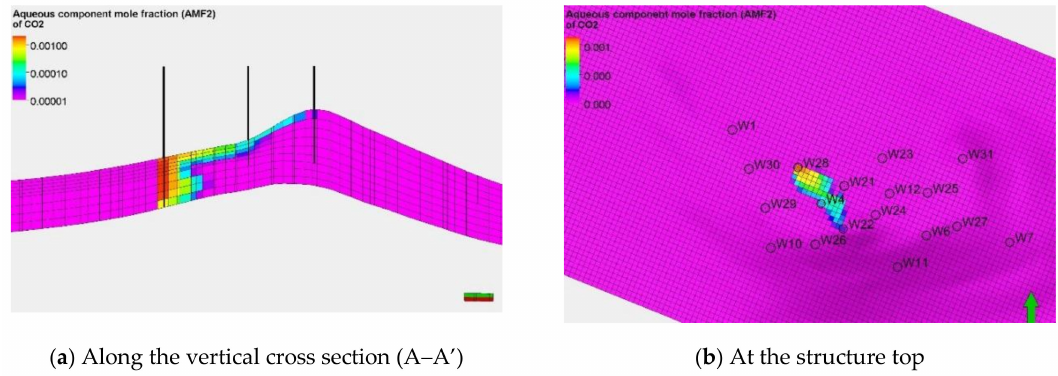
Figure 33. Distribution of CO 2 solution in brine (immobile at S w < 0.1, mobile otherwise) in